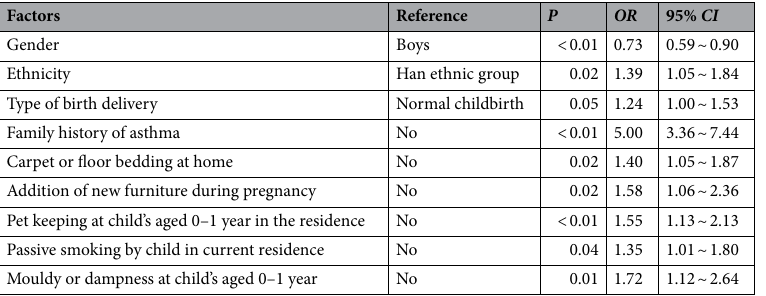
Table 3. Multivariate logistic regression analysis of risk factors for wheeze among preschool children in Urumqi ( n = 8153). OR odds ratio, CI confidence interval.